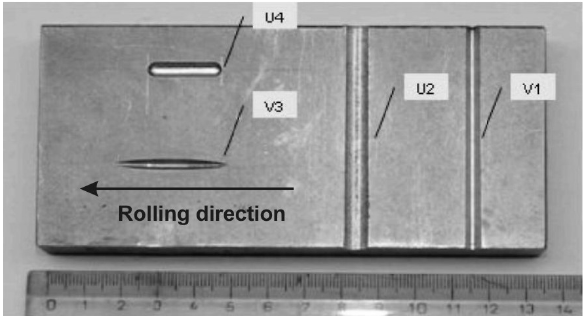
Figure 2a. The location of cracks in the specimen before the physical simulation (top view).